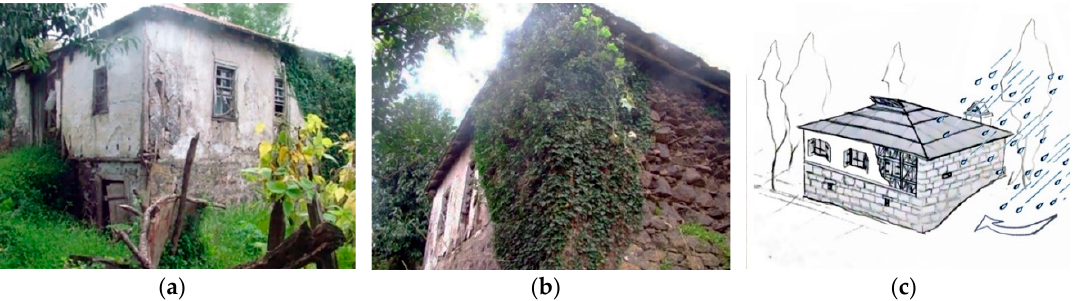
Figure 3. Precaution for Karayel on a vernacular house: ( a ) north-east facade of the building in Giresun (Photographed by Ömer Faruk Bayram); ( b ) north-west facade of the same building (Photographed by Ömer Faruk Bayram); ( c ) illustration of the precaution for Karayel (Drawn by Ömer Faruk Bayram).